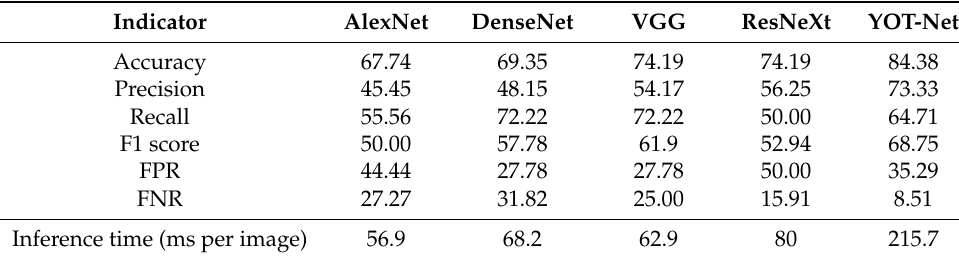
Table 2. Comparisons with the deep learning classification